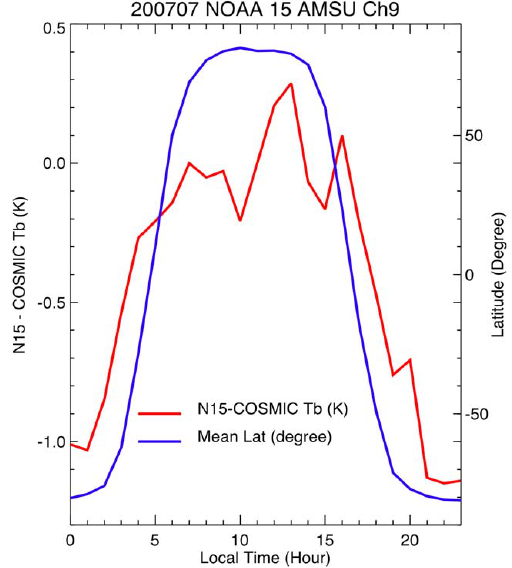
Fig. 35. NOAA-15 AMSU brightness temperatures (Tb) minus COSMIC Tb as a function of local time. Since the RO brightness temperatures are not affected by temperature variations of the satel- lites, the differences in Tb between the COSMIC and the NOAA-15 data are an indication of local-time biases in the NOAA-15 data. As shown in this figure, these differences follow a pattern similar to the mean latitude vs. local time (Ho et al.,